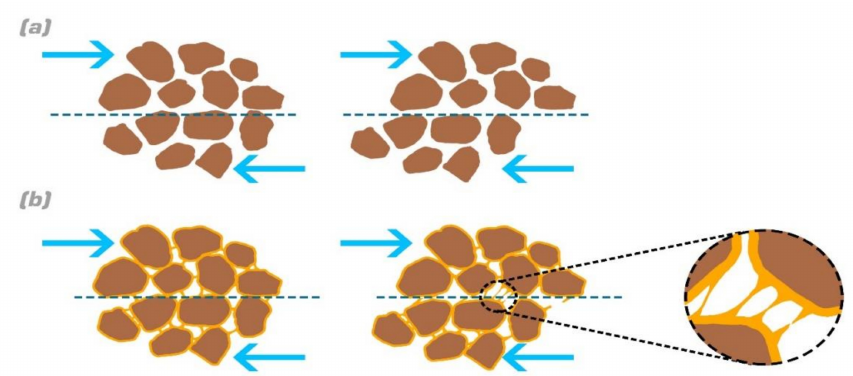
Figure 7. Schematic patterns of sand motion under direct shear testing: ( a ) natural sand state, ( b ) biopolymer-treated